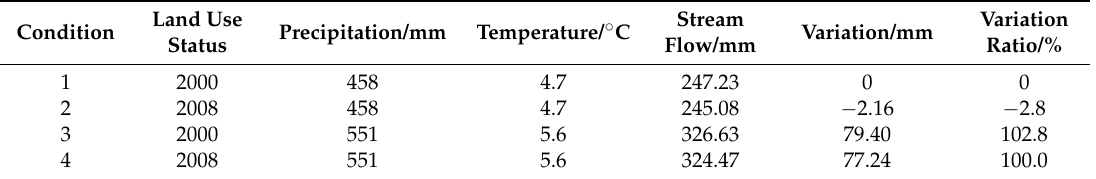
Table 4. Streamflow under different conditions of climate and land use defined by the preset scenario (b).